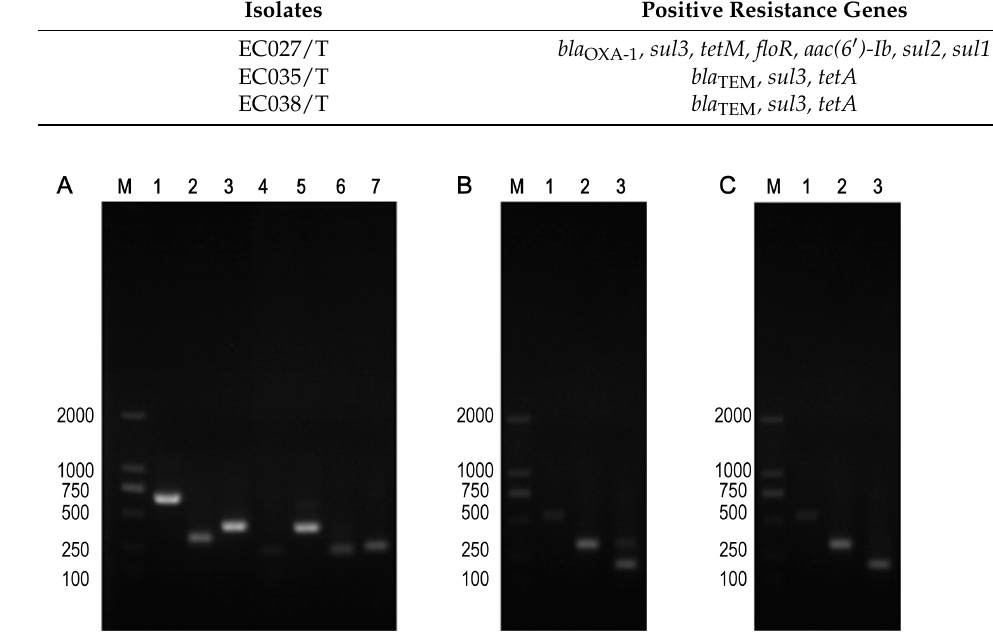
Figure 2. Three transconjugants strains contained drug resistance genes. ( A ) EC027/T, Note: M: 2000 DNA Marker; Lanes 1–7: bla OXA-1 , sul3, tetM, floR, aac(6’)-Ib, sul2, sul1 . ( B ) EC035/T, note: M: 2000 DNA Marker; Lanes 1–3: bla TEM , sul3, tetA . ( C ) EC038/T, note: M: 2000 DNA Marker; Lanes 1–3: bla TEM , sul3, tetA